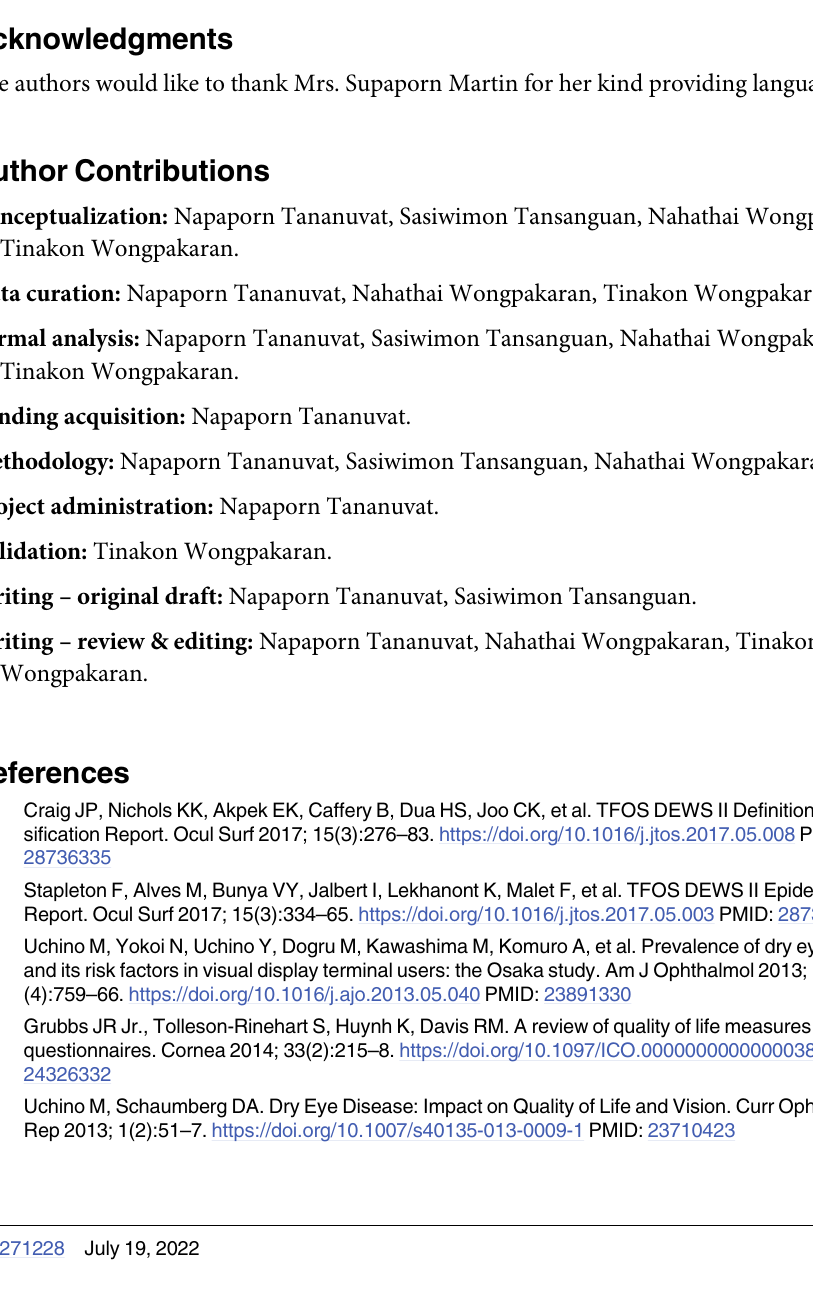
S1 Table. Criterion values of the DEQS-Th and coordinates of the ROC curve. DEQS-Th, the Thai version of the Dry Eye-Related Quality-of-Life Score; ROC, the receiver operating characteristic. S2 Table. Criterion values of the Short Form DEQS-Th and coordinates of the ROC curve. DEQS-Th, the Thai version of the Dry Eye-Related Quality-of-Life Score; ROC, the receiver operating